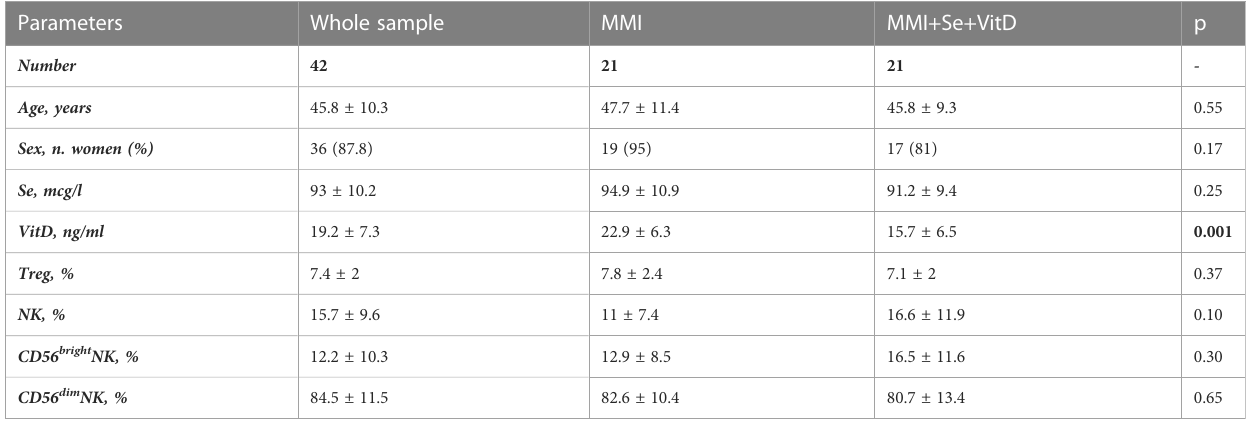
TABLE 1 Baseline main demographic, clinical and biochemical features of 42 GD patients